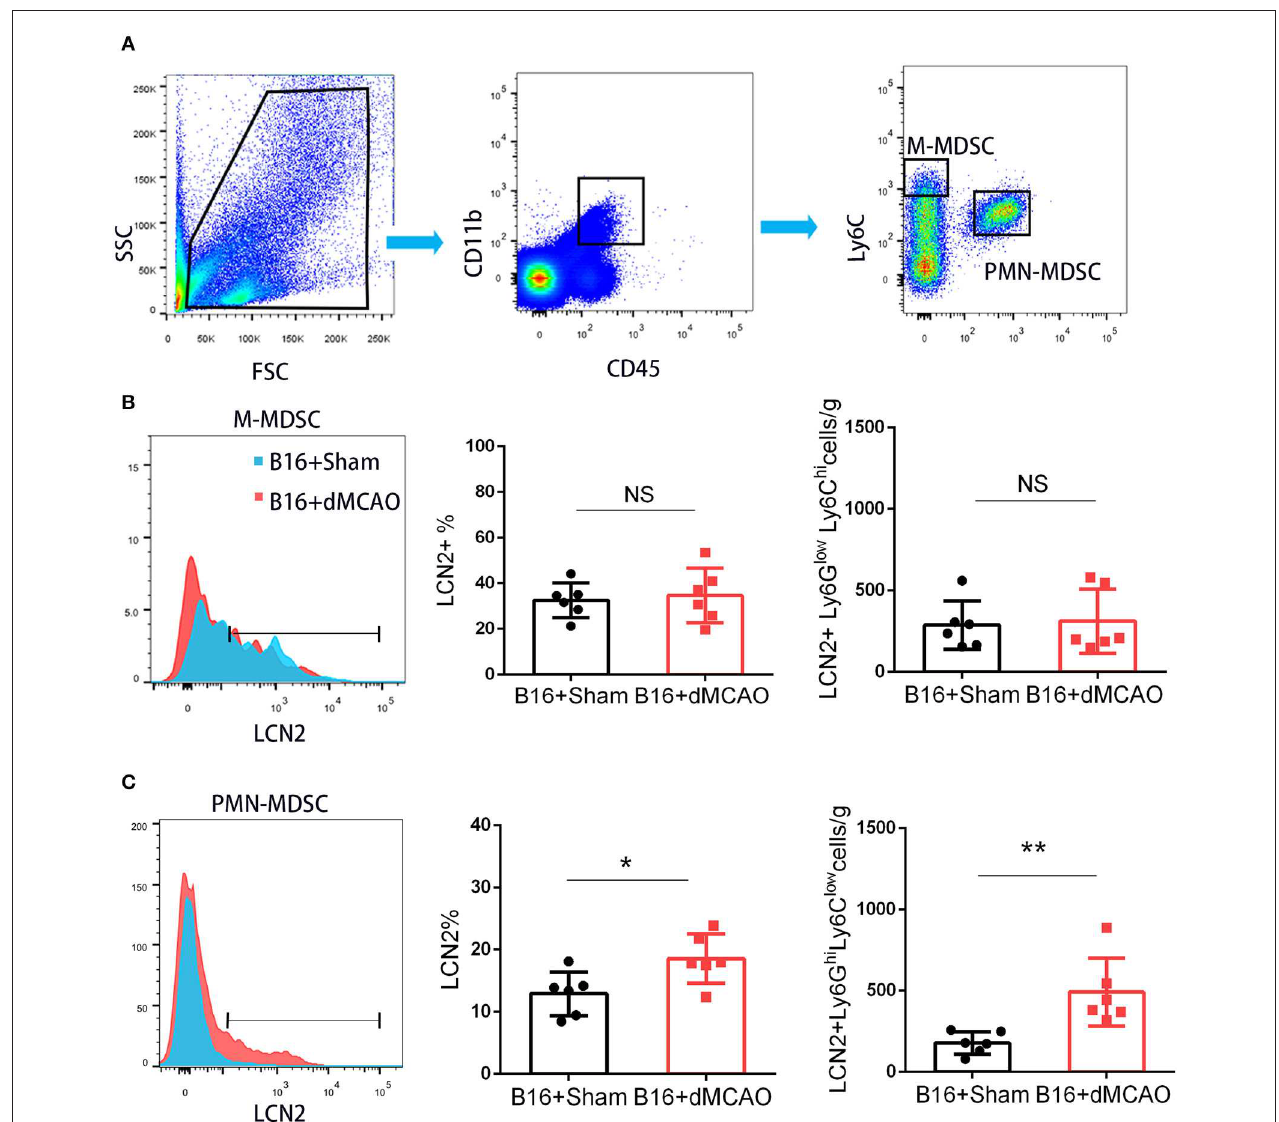
FIGURE 5 | PMN-MDSC may be the major source of the increased LCN2 in the tumor after stroke. (A) Gating strategy of the MDSC populations in the tumor 3 days after sham or stroke surgery. (B,C) LCN2 expression in M-MDSC (CD45 + CD11b + Ly6G low Ly6C hi ) and PMN-MDSC (CD45 + CD11b + Ly6G hi Ly6C low ) in the tumor tissues after stroke ( n = 6/group. * P ≤ 0.05, ** P ≤